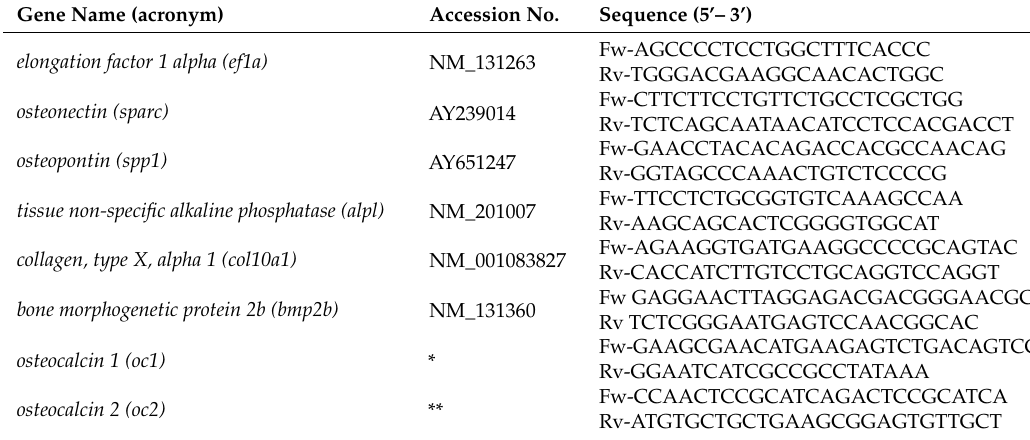
Table 3. Primers used to assess levels of gene expression by qPCR.